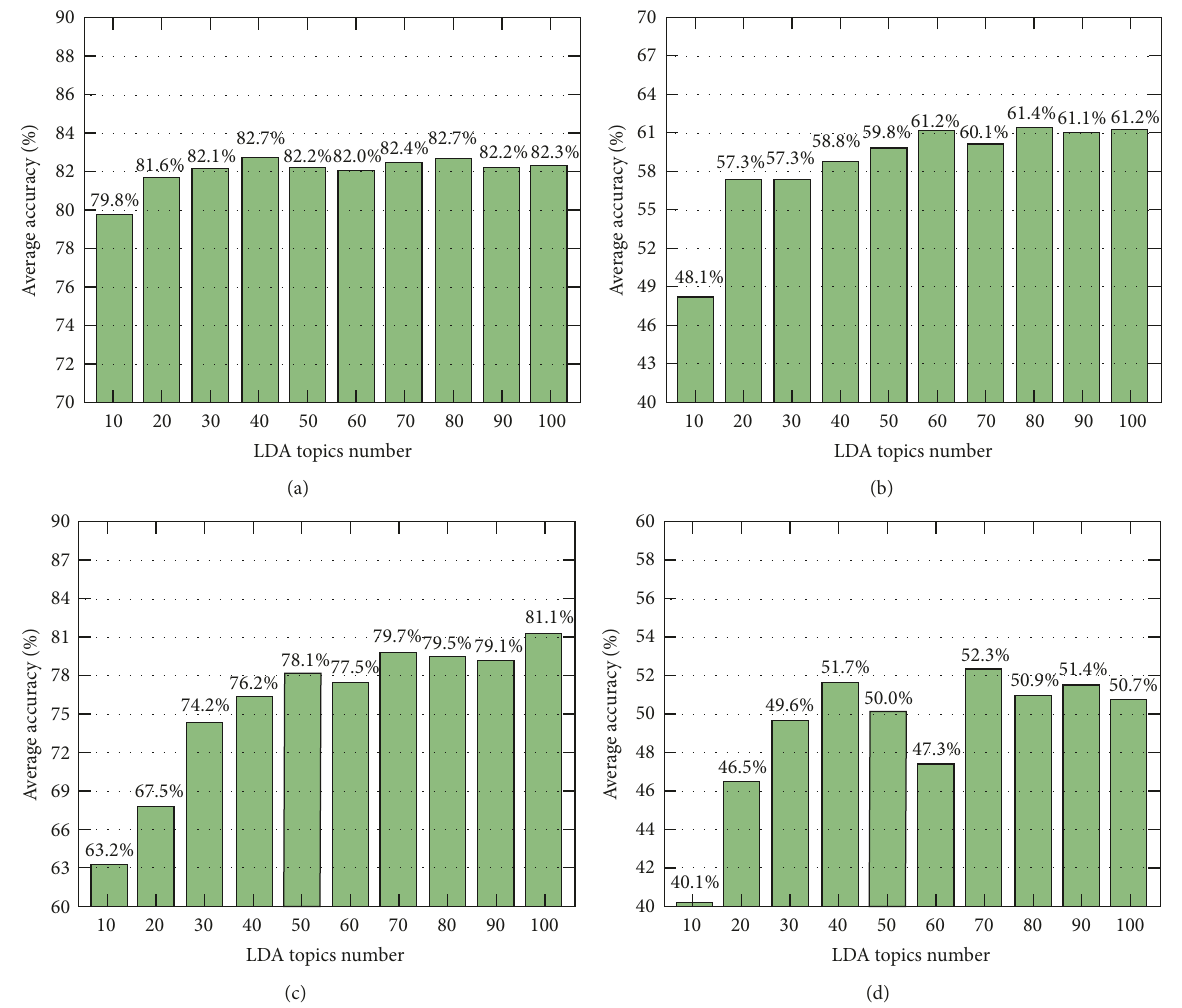
Figure 13: Average accuracy of (a) FrameDiff GridBlock Top , (b) MultiCue GridBlock Top , (c) FrameDiff GridIntersect Top , and (d) MultiCue GridIntersect Top , with 𝐾 ranging from 10 to 100 and 𝑐 ranging from 10 to